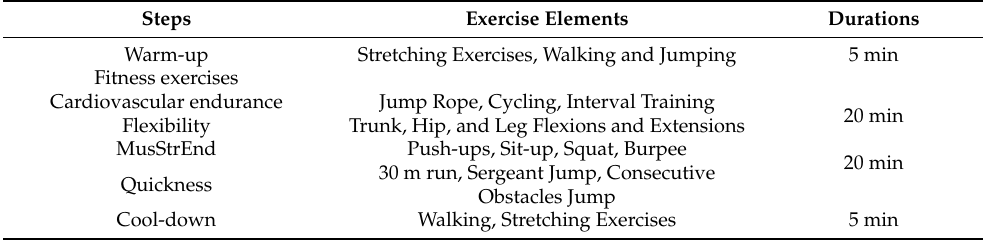
Table 1. Contents of HrPF